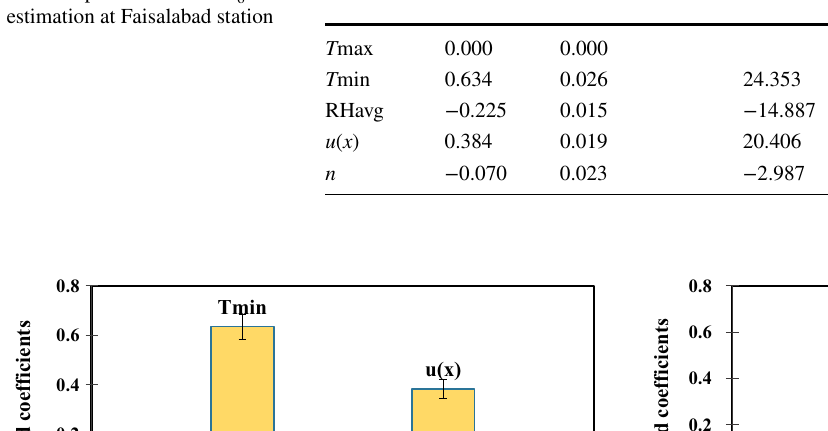
Table 4 The regression analysis for identifying the most effective parameters for ET o estimation at Faisalabad station